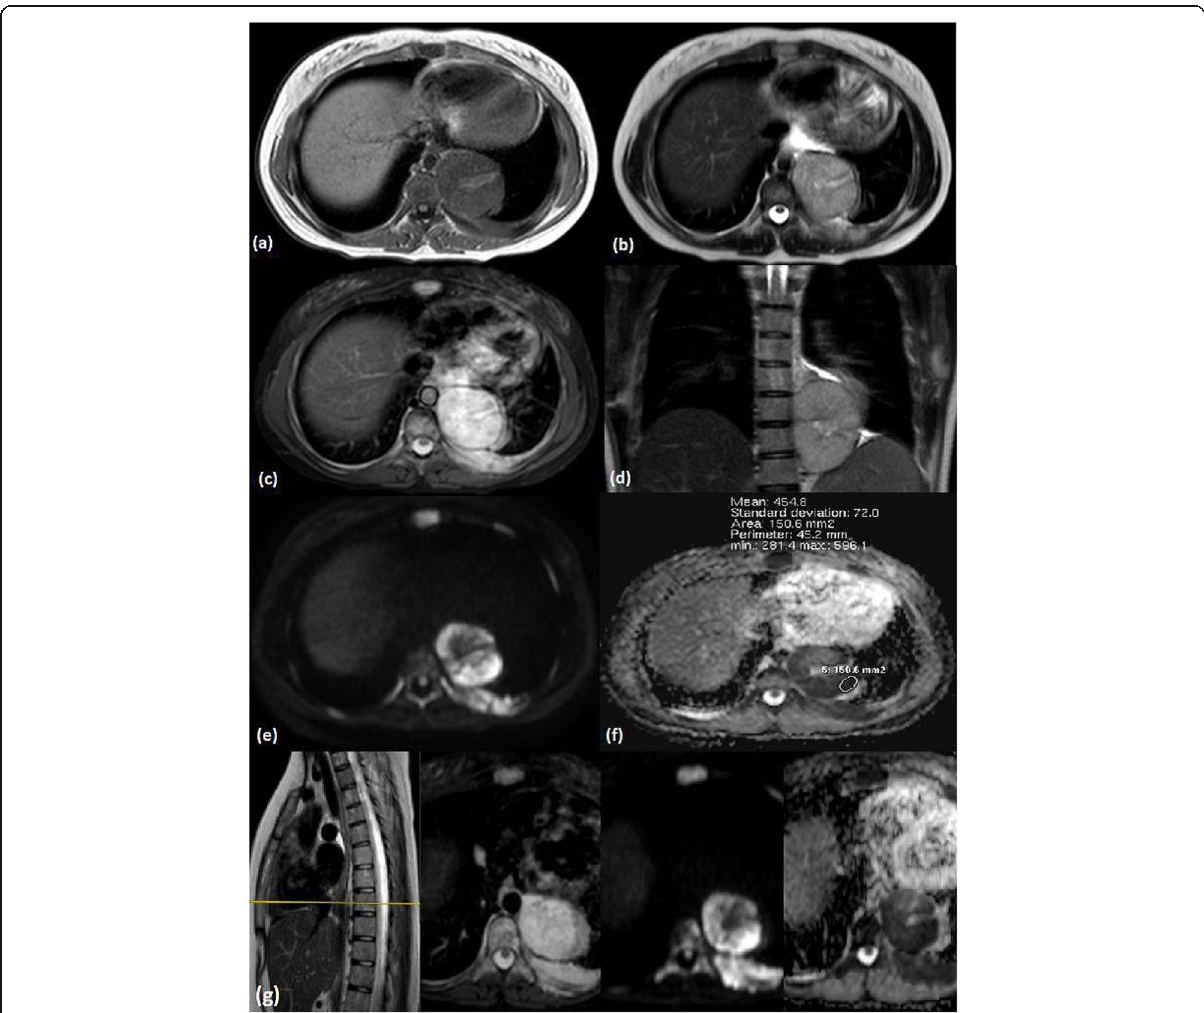
Fig. 2 Ganglioneuroblastoma: A 16-year-old female with a posterior mediastinal (left paravertebral) mass identified on CT. The patient clinically presented with dorsal back pain radiating to the right upper limb and bilateral hip pain with a history of blood transfusion to correct anemia. a Axial T1 WI, b and d axial and coronal T2 WI and c STIR WI show a well-defined oval-shaped posterior mediastinal (left paravertebral) mass displaying intermediate T1 and bright T2 and STIR signal intensities with a central scar showing bright signal on all three pulse sequences. Mass is centered on the adjacent neural exit foramina with no definite neural foraminal or intraspinal extension. Invasion of the posterior aspects of the adjacent ribs is seen in the form of soft tissue encasement. Associated patchy altered MR marrow signal of the examined bones is seen most evident on g axial STIR and DWI and the ADC map (from left to right). The mass shows restricted diffusion by being bright on e DWI and dark on the f ADC map: ADC mean = 0.473 × 10 − 3 mm 2 /s and ADC min = 0.327 × 10 − 3 mm 2